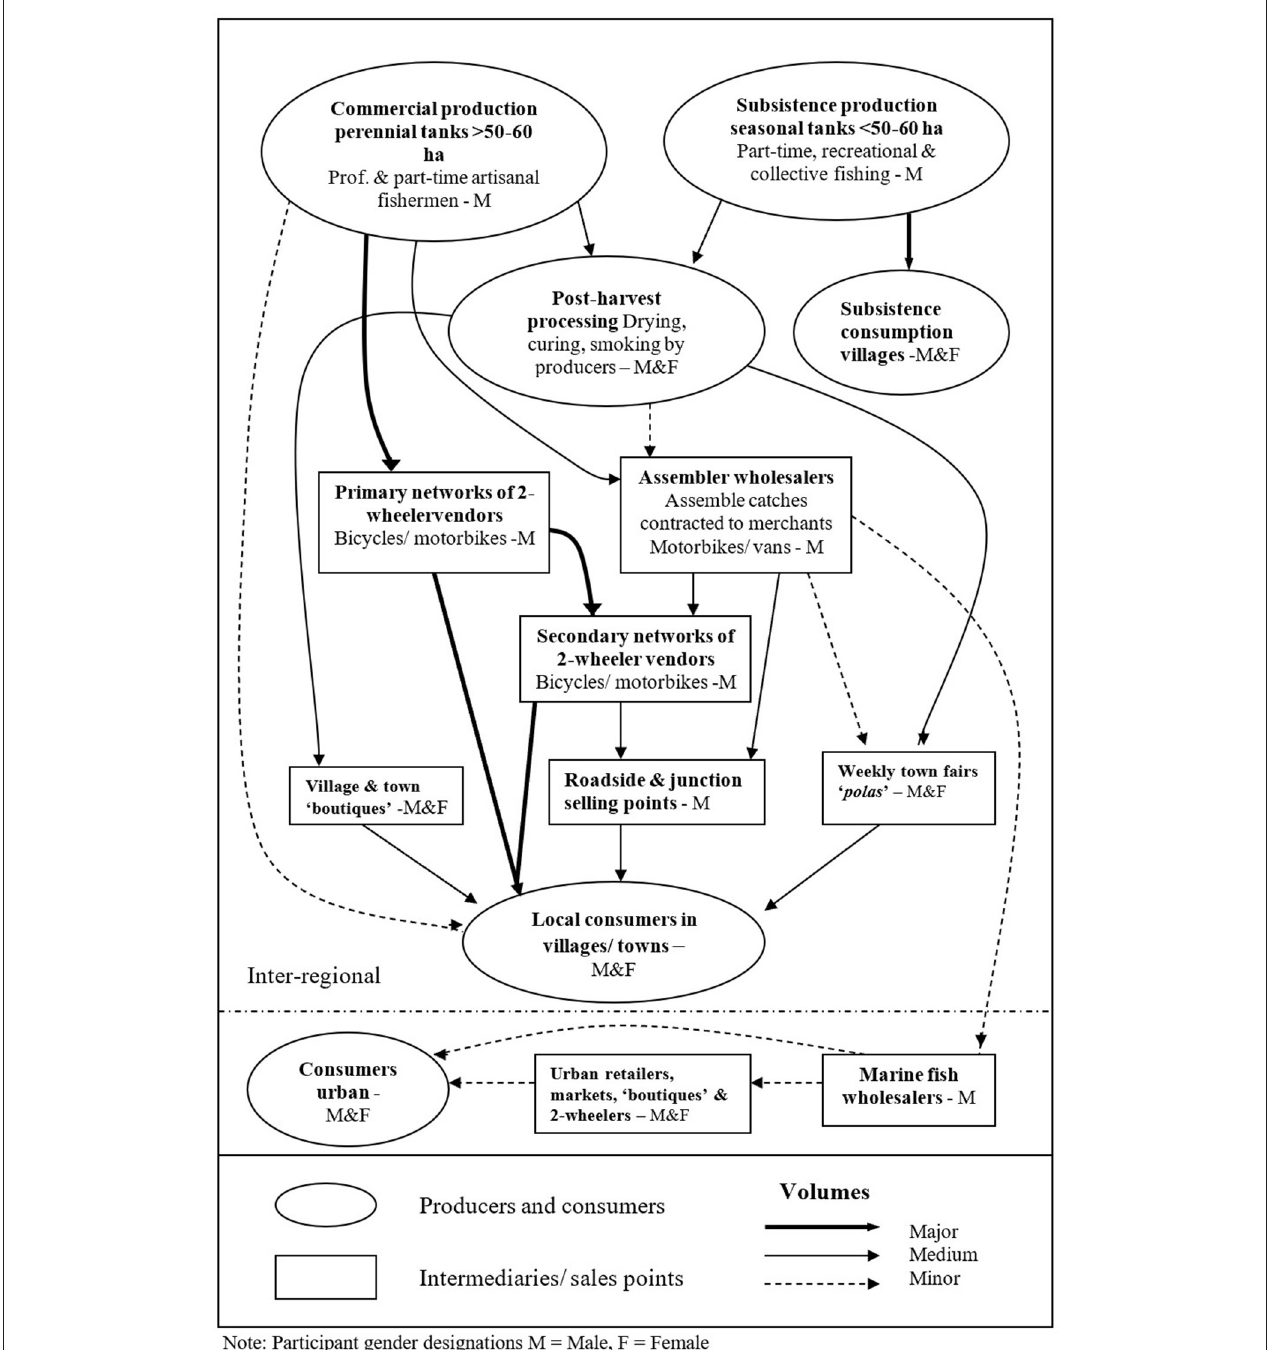
FIGURE 3 | Marketing chains for inland and marine fish in Northwest Province, Sri